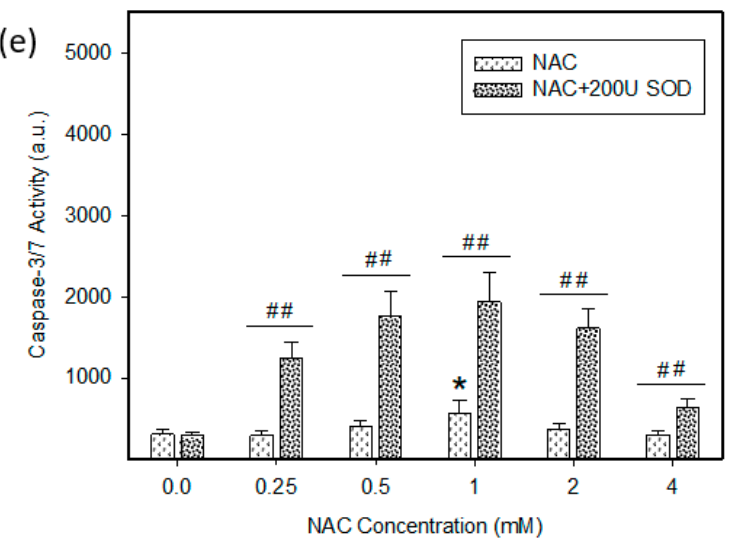
Figure 8. Effect of NAC on cell death features in U937 cells. Cells were treated with NAC or with NAC in combination in SOD as indicated. After 24 h incubation, cell death features were analyzed. ( a ) Effect on nuclear morphology. Pictures represent typical examples. ( b ) Effect on nuclear morphology—a quantitative analysis. Points represent mean from three independent experiments with standard errors. ( c ) Effect on DNA fragmentation (hypodiploid DNA content). Histograms represent typical examples. ( d ) Effect on caspase-9 activation. Points represent mean from three independent experiments with standard errors. ( e ) Effect on caspase-3/7 activation. Points represent mean from three independent experiments with standard errors. * denotes significant difference in the caspase activity ( p < 0.05) between the NAC treated and untreated (control) cells. # / ## denotes significant/very significant difference in the caspase activity ( p < 0.05/ p < 0.01) between the indicated treatments.